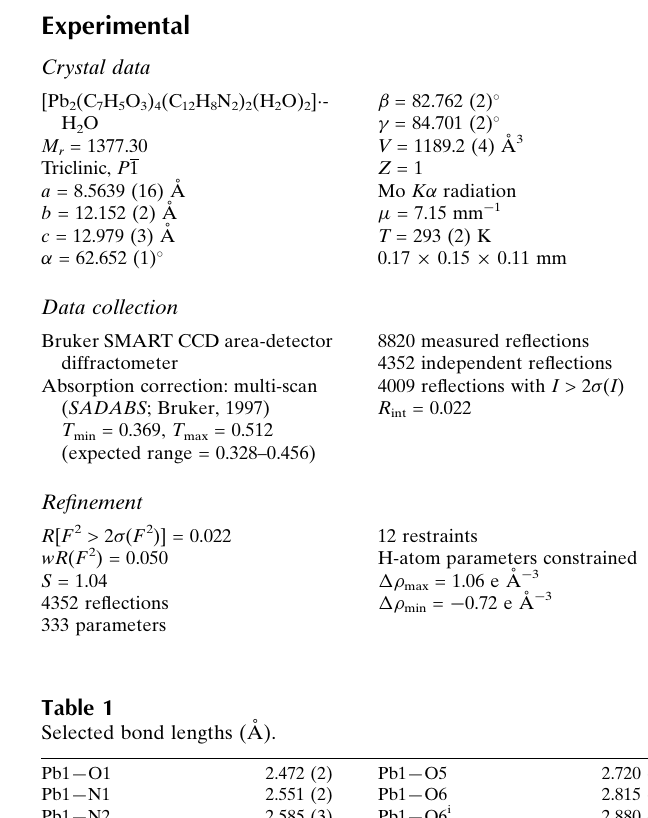
parameter ratio = 13.1.